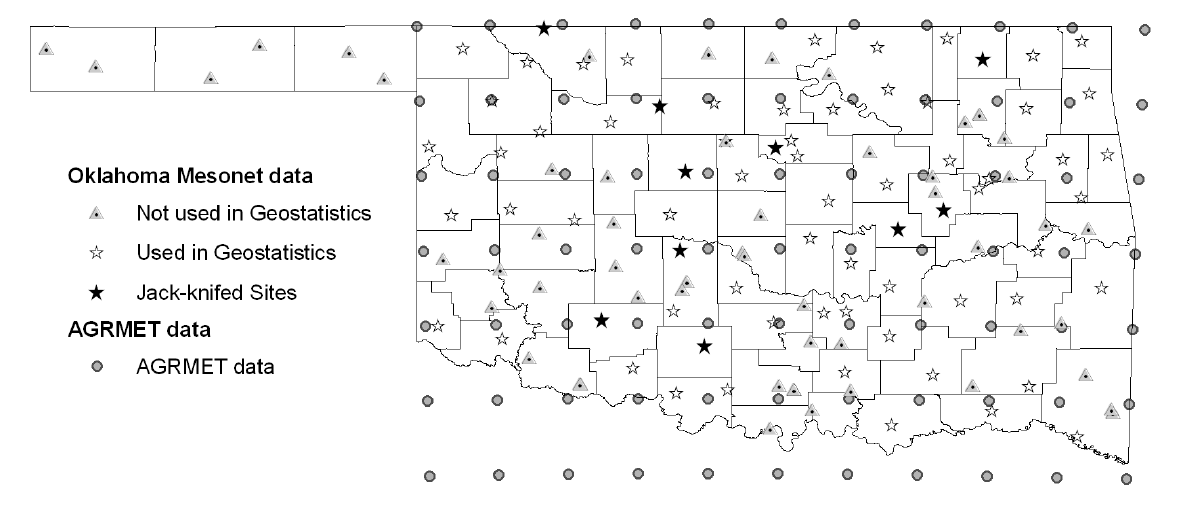
Figure 2. The distribution of AGRMET grid points and Oklahoma Mesonet sites used in the geostatistical